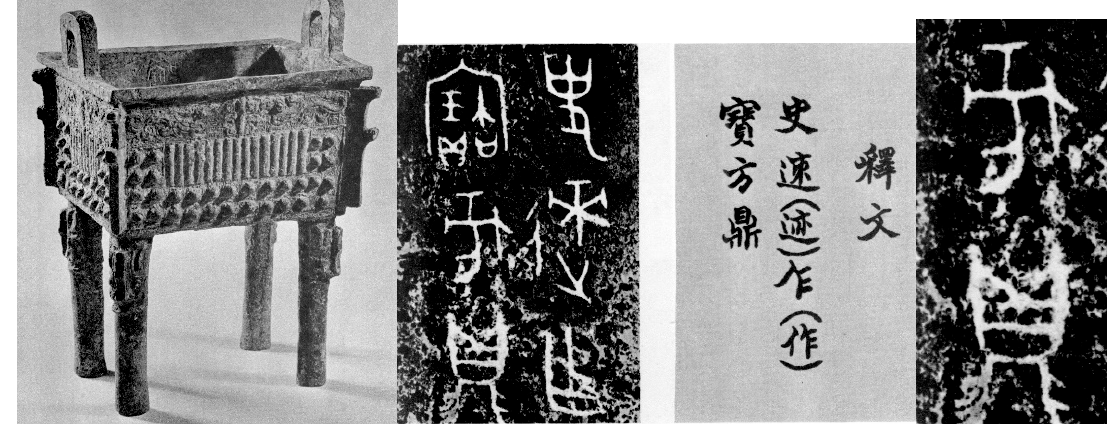
Figure 4. One of a pair of Shi Yi fangding. Shaanxi volume: Figure 154, page 135.